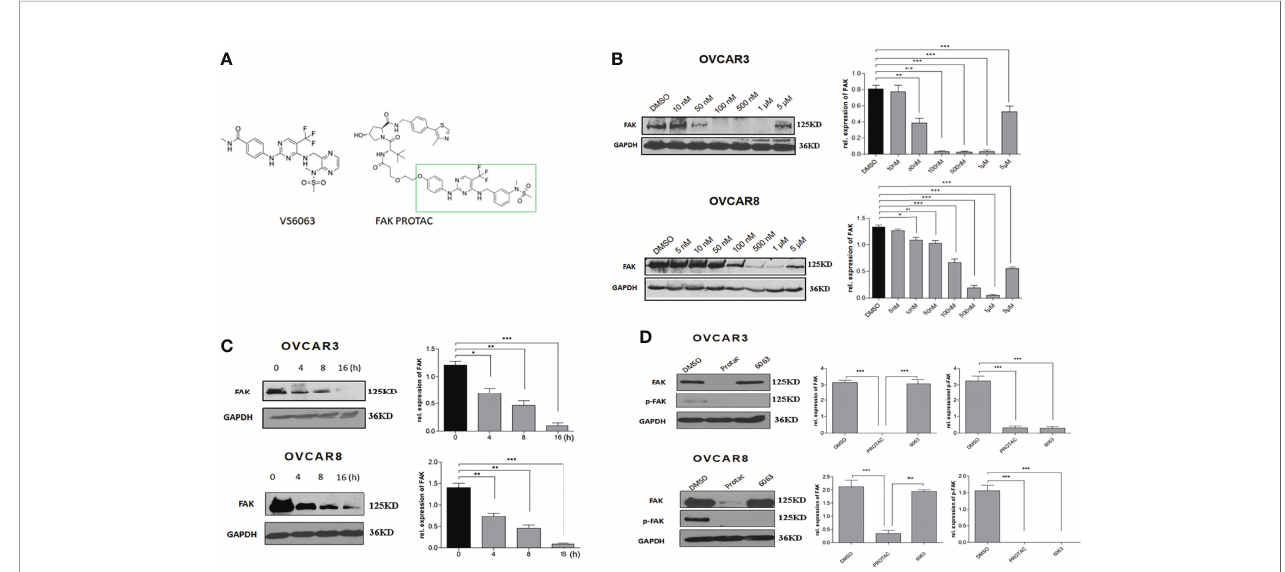
FIGURE 2 | FAK PROTAC inhibits both FAK activity and degrades FAK protein. (A) FAK PROTAC binds FAK kinase inhibitor VS6063 and ubiquitin ligase E3. (B) WB analysis of FAK protein in both OVCAR3 and OVCAR8 cells following 24 h treatment at different doses. (C) WB analysis of FAK following 1 µM FAK PROTAC treatment at different time points. (D) WB analysis of FAK and pFAK in both OVCAR3 and OVCAR8 cells following 24 h treatment with 1 µM FAK PROTAC and VS6063. (* p <0.05; ** p <0.01; *** p